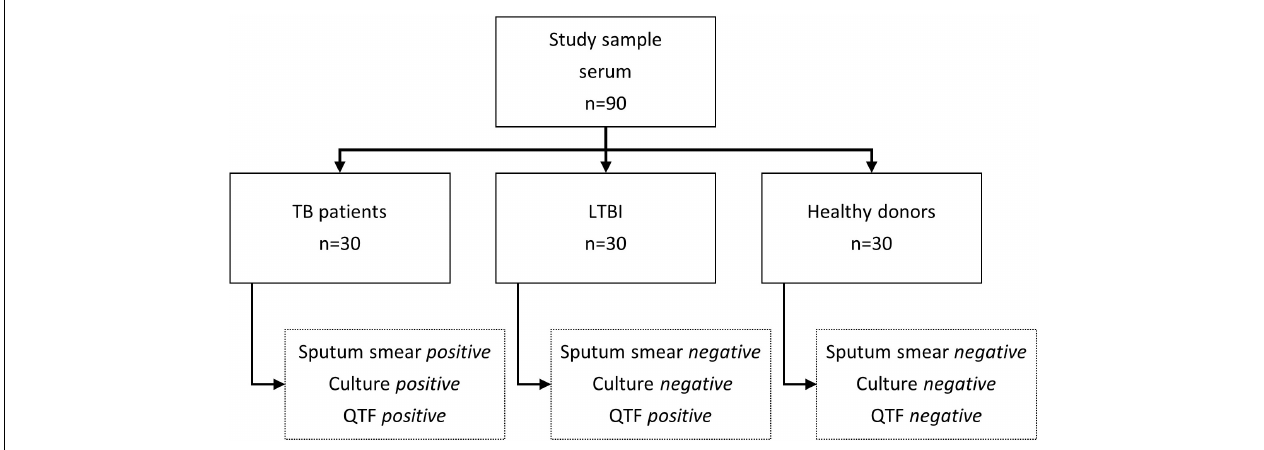
FIGURE 3 | Schematic representation of the characteristics of the serum samples used in the study. TB, tuberculosis, LTBI, Latent tuberculosis infection, QTF, QuantiFERON - TB Gold Plus.